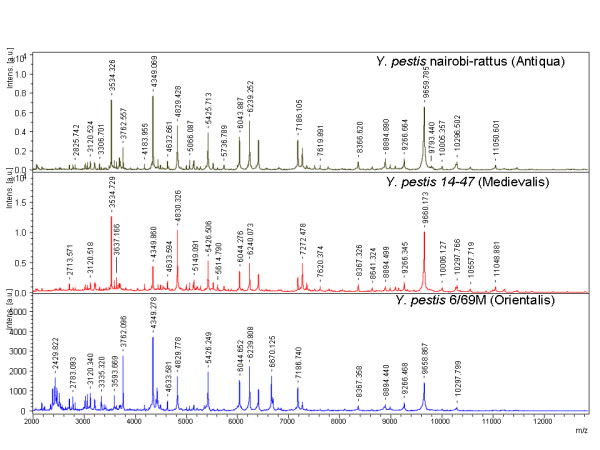
Protein profile of the major Y. pestis biotypes generated by MALDI-TOF-MS. a.i., arbitrary intensity given by the software.